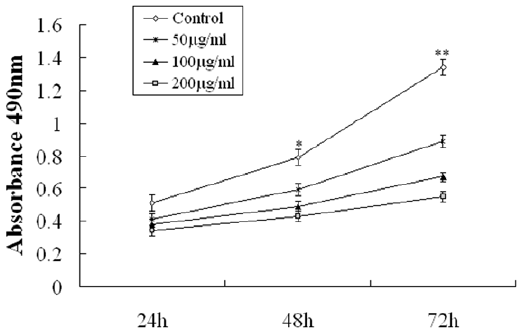
Figure 2. Inhibitory effect of fucoidan on the growth of 4T1 Cells. The 4T1 cells were treated with 50, 100, and 200 m g/ml fucoidan separately for 1d, 2d and 3 d and measured for viability by MTT assay. Data are shown as mean 6 S.D. n=5. * P , 0.05, vs. Control, ** P , 0.01. vs.